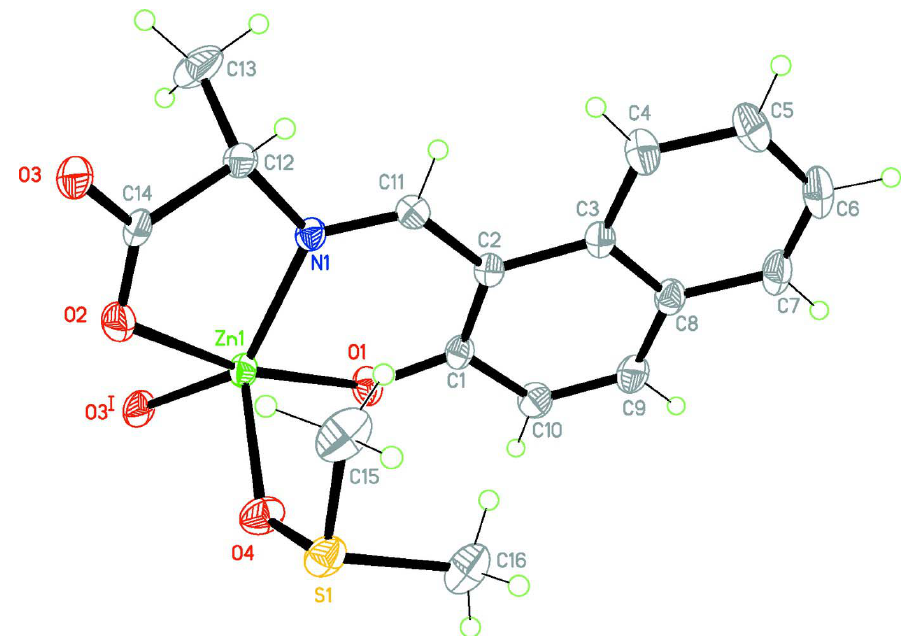
Figure 1 The molecular structure of (I), showing displacement ellipsoids at the 30% probability level for non-H atoms. [Symmetry code: (I) - x + 1, 1/2 + y , - z +